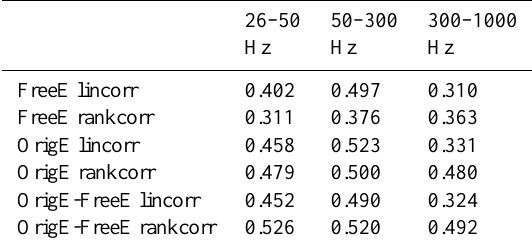
Table 1. Average linear and rank correlation coefficient in the 30 events studied with free and original energy density and their differ- ence as well as PWI wave amplitude in three frequency